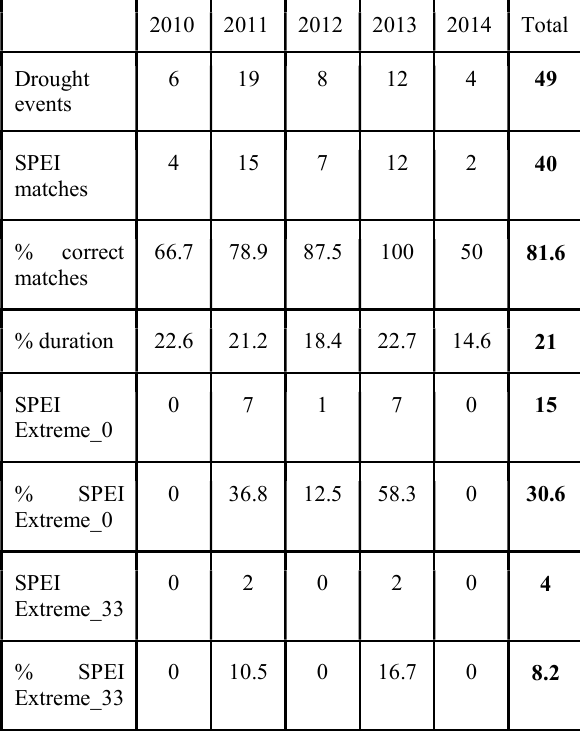
Table 5. Validation results for